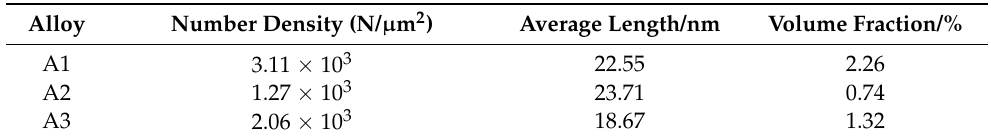
Table 2. The statistics of β ” precipitates in A1, A2, and A3 alloys after paint-bake hardening at 185 ◦ C for 8 h.